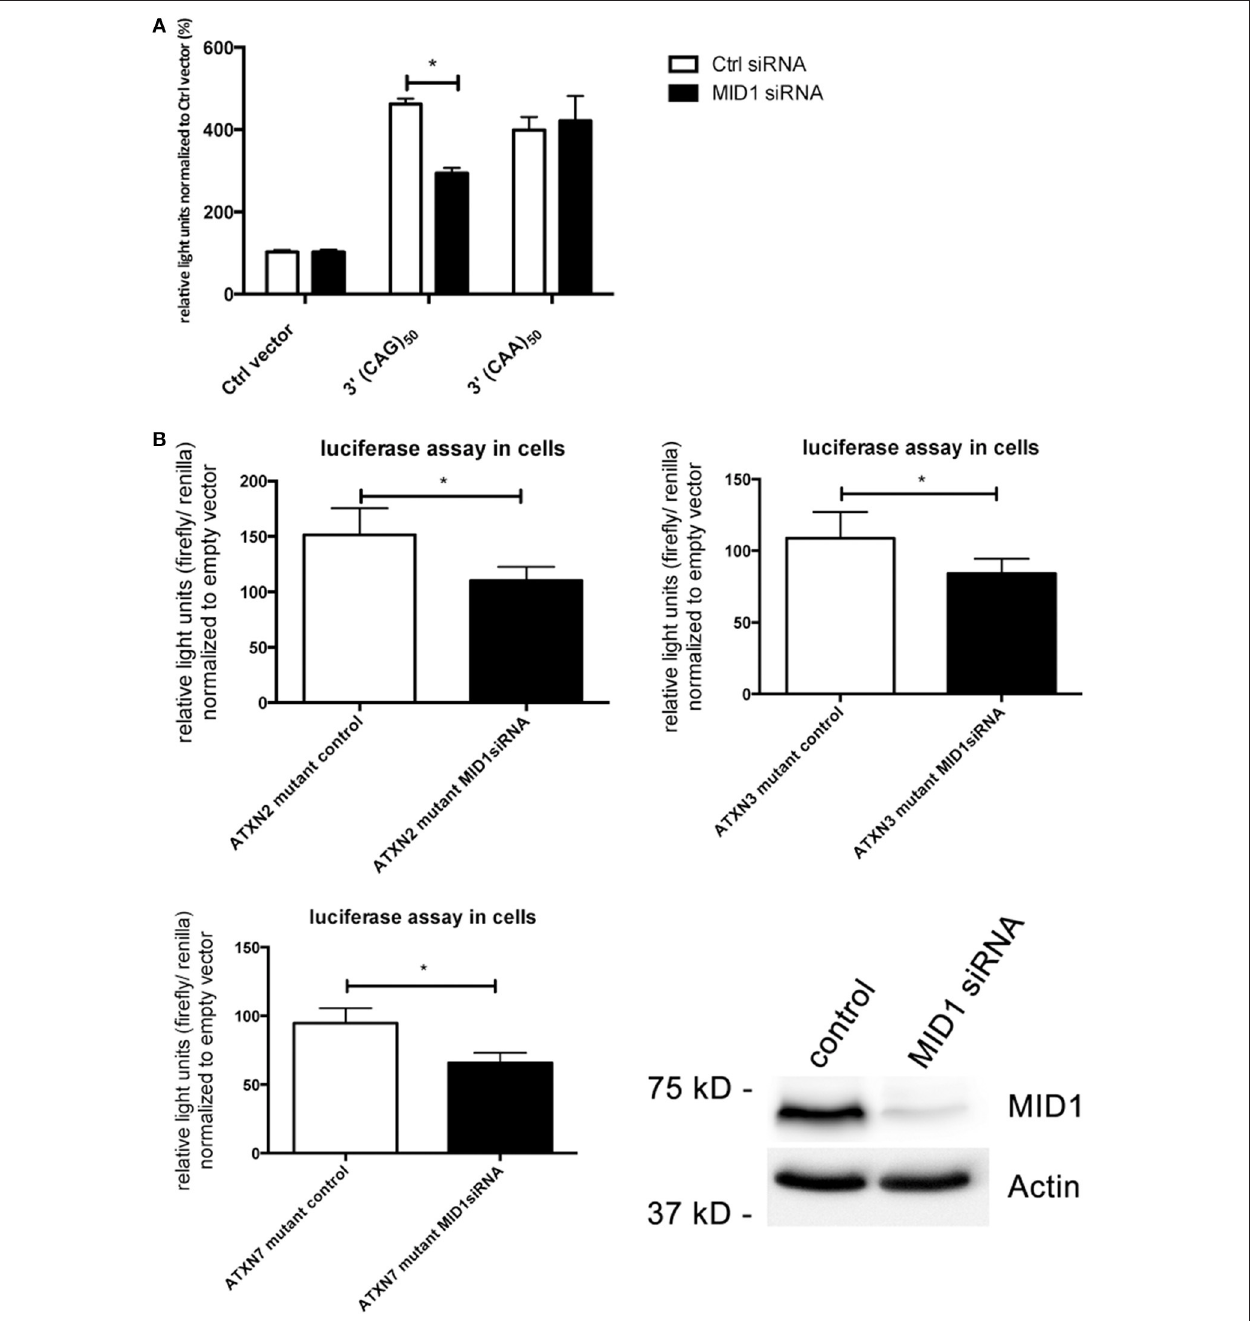
FIGURE 4 | Translation of CAG repeats but not CAA repeats is regulated by MID1. (A) Dual luciferase reporter assay in HEK293T cells co-transfected with MID1 specific or control siRNAs and constructs containing a renilla luciferase reporter with pure CAG repeats or pure CAA repeats in the 3 ′ UTR and firefly luciferase as an internal transfection control. Data shown represent relative light units of renilla luciferase construct normalized to firefly luciferase. Columns represent mean values ± SEM. n = 3, p < 0.0001. (B) Dual luciferase reporter assay in HEK293T cells co-transfected with MID1 specific or control siRNAs and constructs containing a firefly luciferase reporter with the CAG repeat region of ATXN2 , ATXN3 , and ATXN7 in the 3 ′ UTR and renilla luciferase as an internal transfection control. Data shown represent relative light units of the ATXN2 , ATXN3 , and ATXN7 firefly luciferase construct normalized to renilla luciferase. Values were normalized to mean values of empty vectors co-transfecetd with the respective siRNA. Columns represent mean values ± SEM. n = 6, p < 0.0001. To show knockdown efficiency MID1 (upper panel) and actin (lower panel, loading control) were detected on a western blot using specific antibodies. *Indicates statistically significant differences ( p < 0.05).